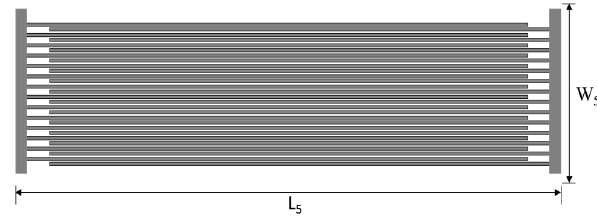
Figure 1. Layout of the proposed sensor’s interdigitated electrode. L 5 = 45.75 mm and W 5 = 20 mm.